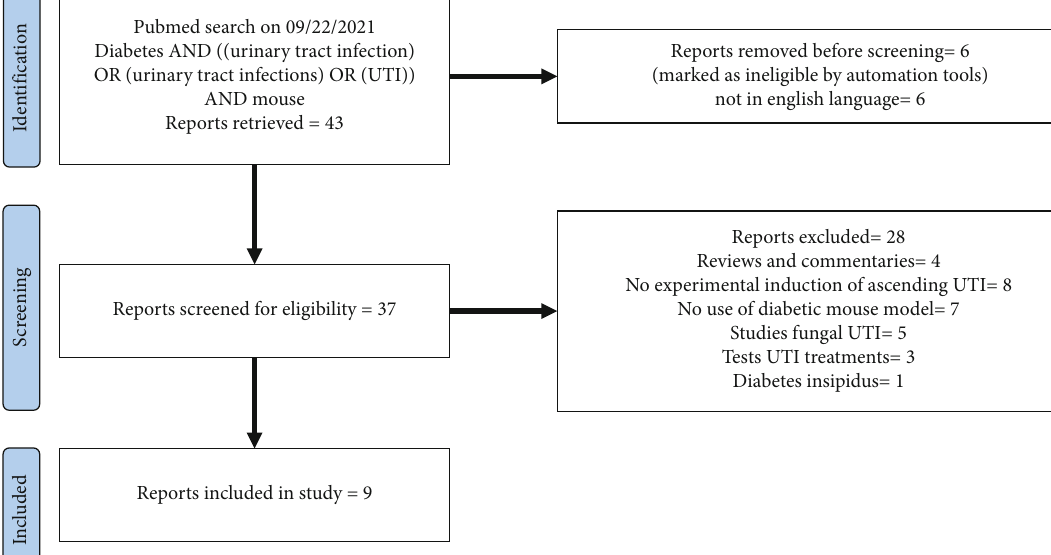
Figure 1: PRISMA fl ow diagram of describing inclusion and exclusion criteria for experimental